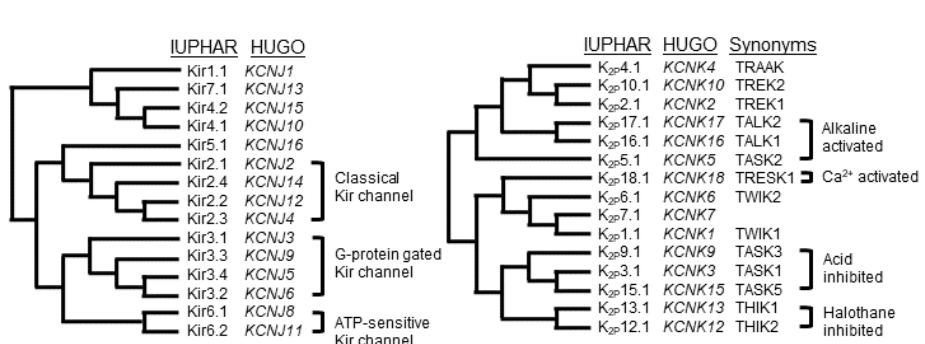
Figure 3. Phylogenetic tree topology of K + channels, voltage-gated K + (K V ) channels ( A ), Ca 2+ -activated K + channels ( B ), inward-rectifier K + (Kir) channels ( C ), and two-pore K + (K 2P ) channels ( D ).